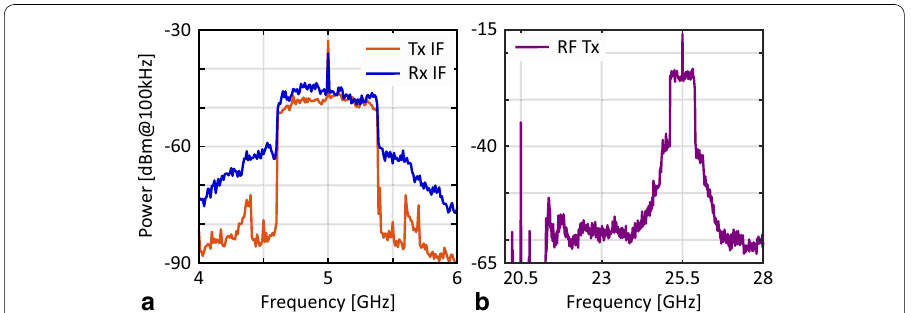
Fig. 6 Measured electrical spectra of a the transmitted and received IF signals and b the transmitted mm-wave RF signal. IF: intermediate frequency, RF: radio